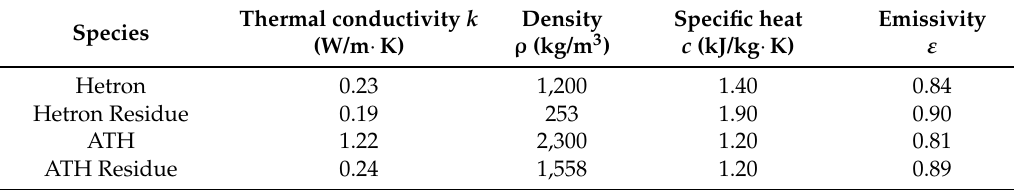
Table 3. Species thermal properties.